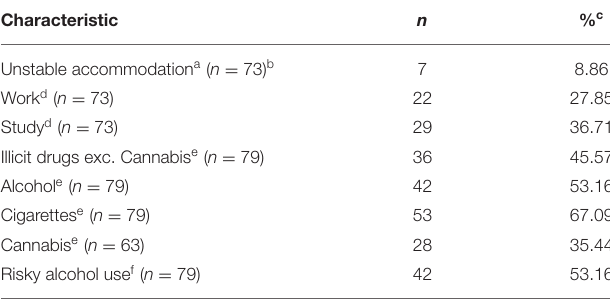
TABLE 2 | Baseline characteristics ( N =